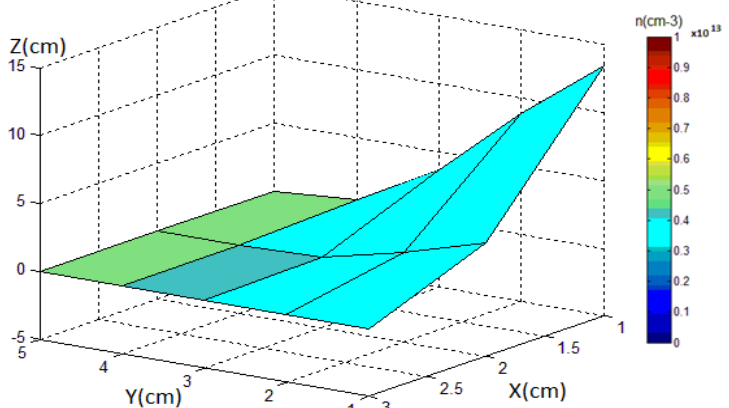
Figure 4: The spatial profile of electron number density of carbon laser induced plasma at z=2cm.